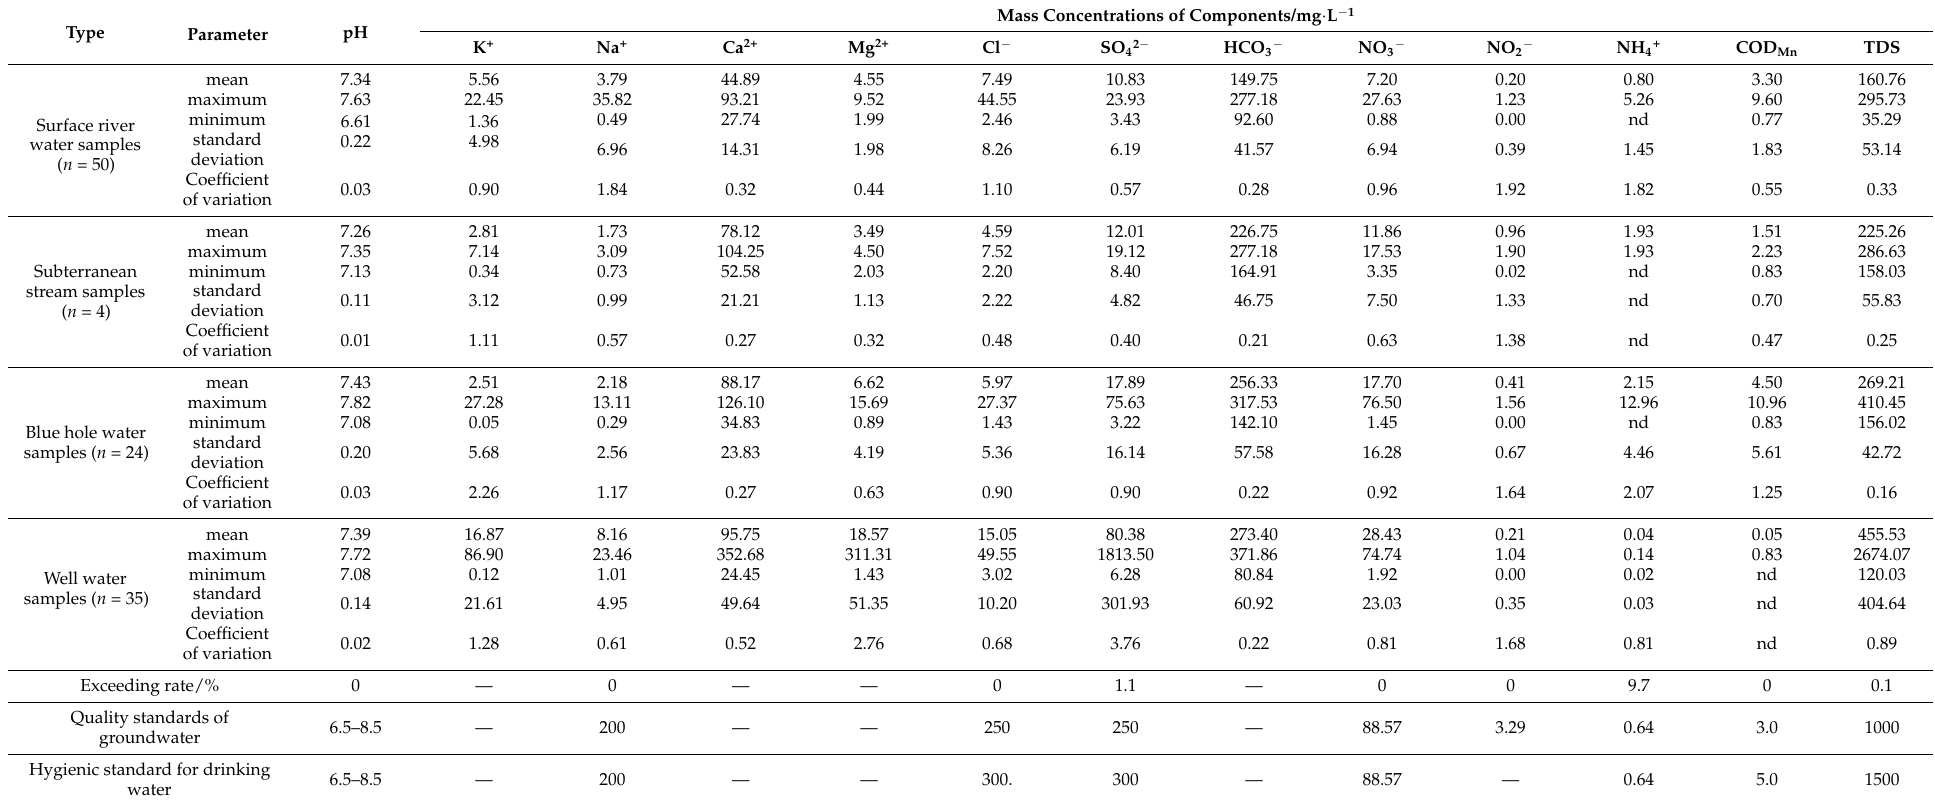
Table 1. Hydrochemical characteristics of groundwater of the Huixian karst